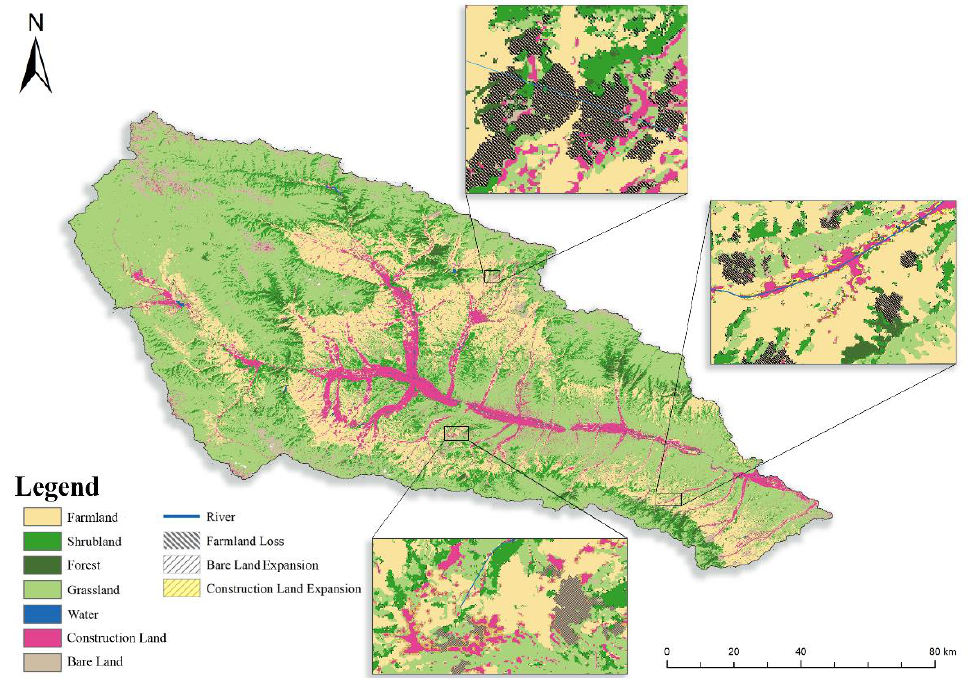
Figure 4. Simulation results of land use function and structure in Huangshui watershed in 2035.(WGS 84,1 : 1 000 000)